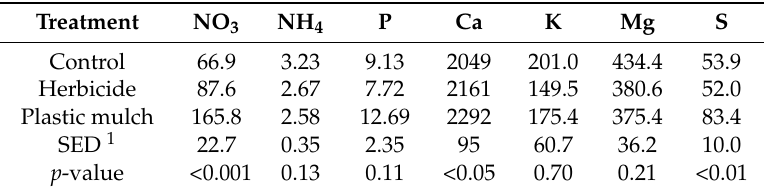
Table 3. Vegetation treatment effect on the supply rate (µg/10 cm 2 /30 days) of various soil elements measured during the fifth growing season in an agricultural riparian buffer.